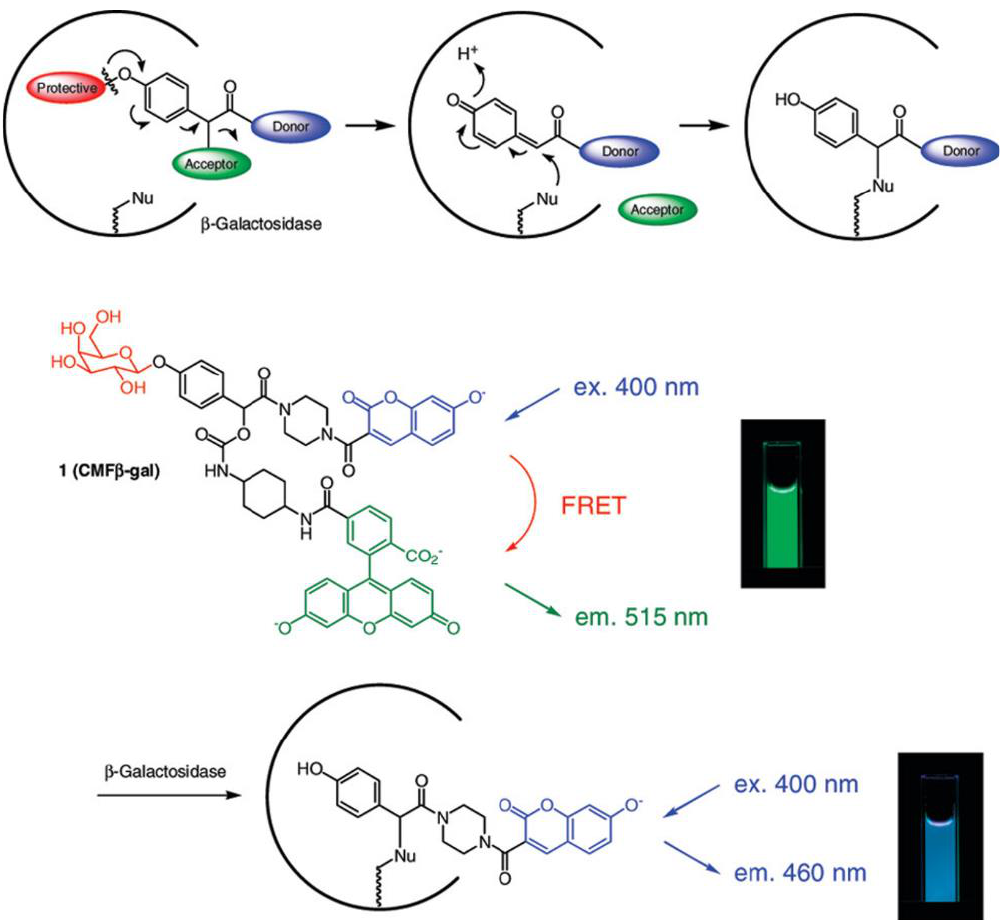
Figure 8. FRET- based β - galactosidase activatable probe CMFβ -gal. Reprinted with permission from Figure 8. FRET-based β -galactosidase activatable probe CMF β -gal. Reprinted with permission [47], copyright 2006 American Chemical Society . from [47], copyright 2006 American Chemical